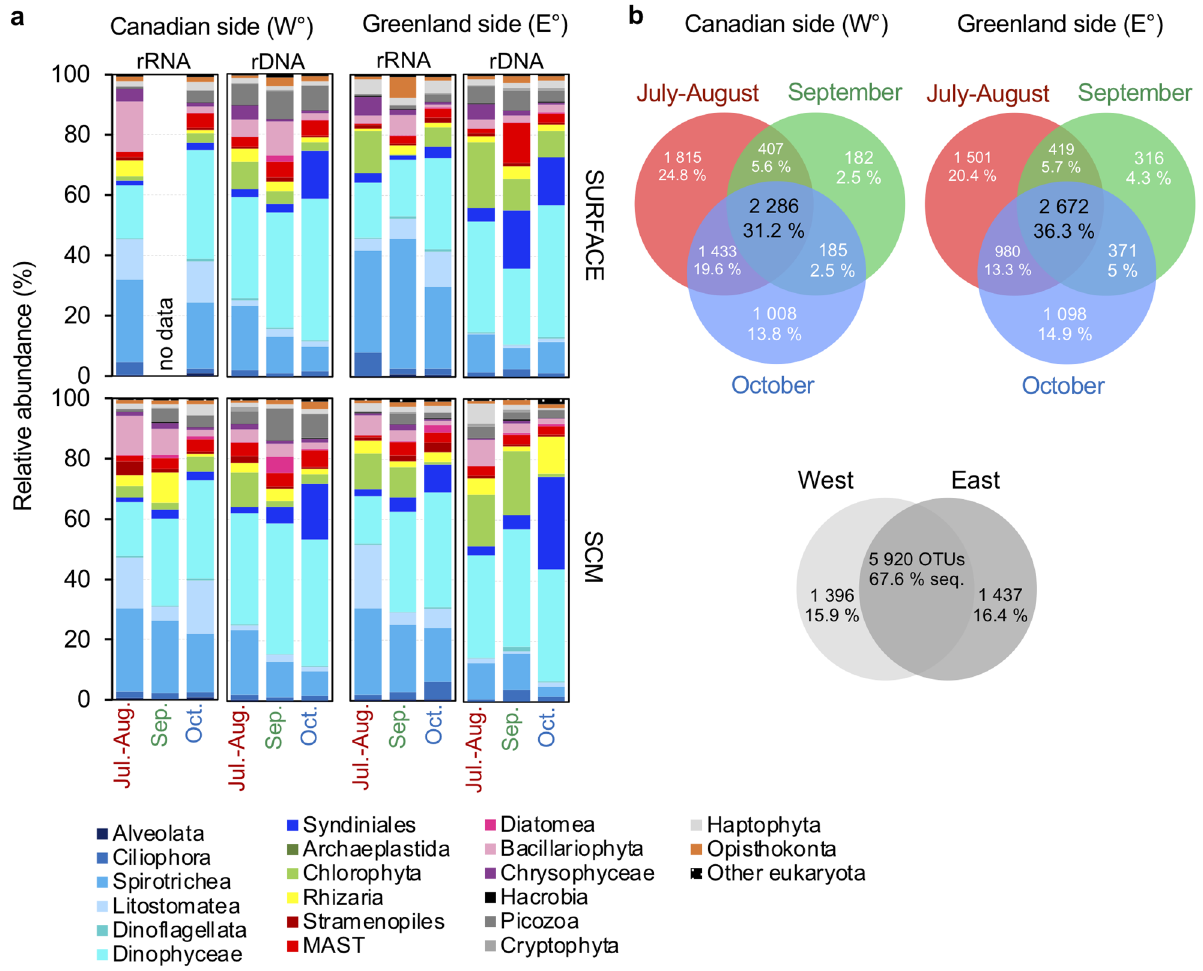
Figure 4. Seasonal and sides comparison of community composition. ( a ) Eukaryotic phytoplankton 18S rRNA gene OTUs community composition. Relative abundance by month of sampling (see dates of sampling in Supplementary Table S1) of both depths and sides. ( b ) Venn diagrams showing the number of unique and shared OTUs detected by 18S rRNA sequencing comparing the three-time frames (July–August, September and October) of the two sides of the North Water from 2005 to 2018. Lower Venn diagram shows overlap of communities between the two sides for all years, with the corresponding percentage of the total OTUs in combined rRNA and rDNA